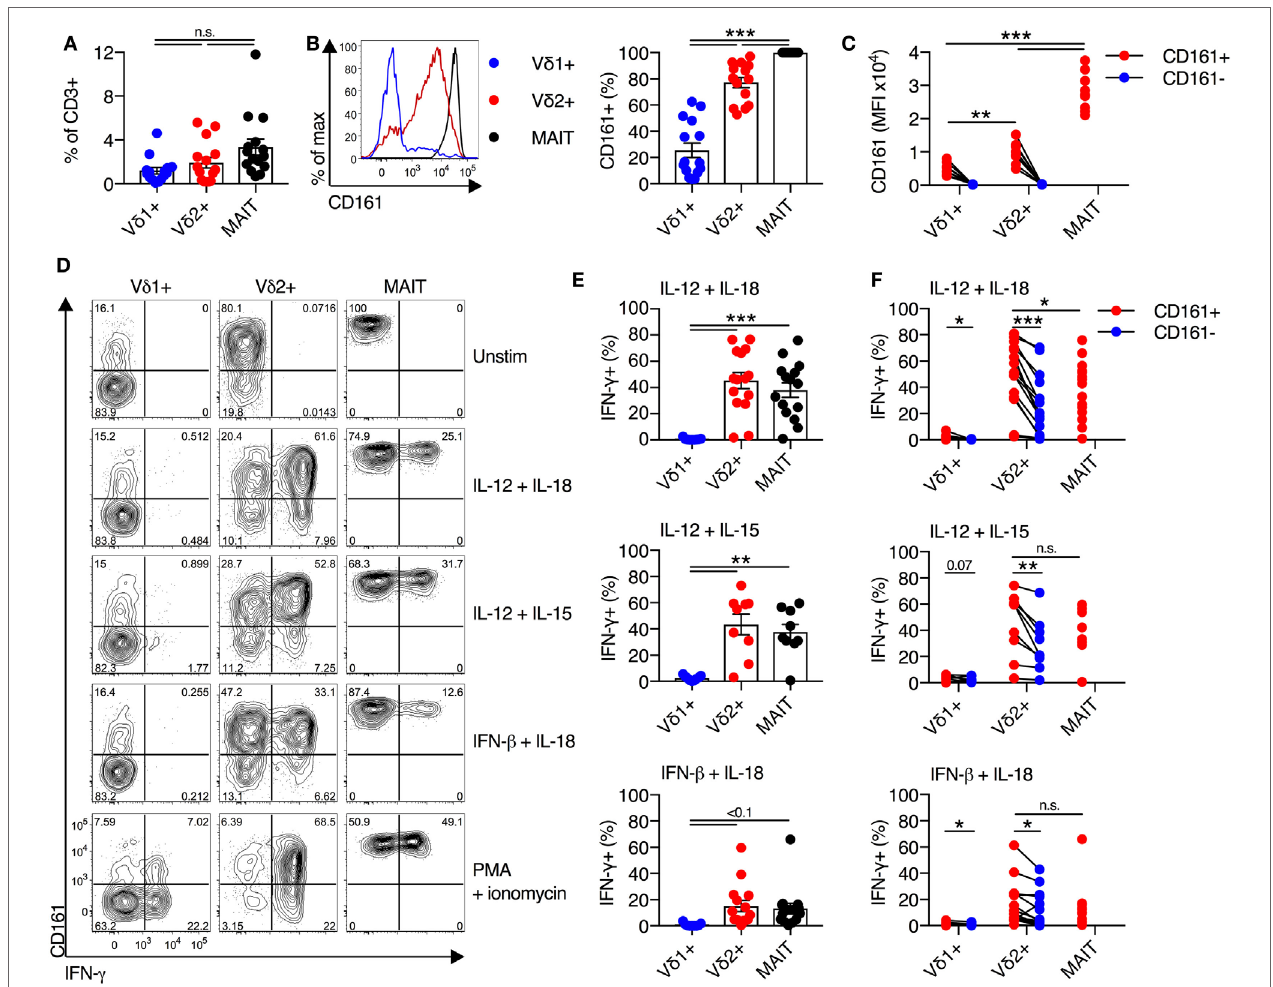
FigUre 1 | V δ 2 + γδ T cells express CD161 and produce IFN- γ in response to cytokine stimulation. (a) Frequency of V δ 1 + γδ T cells, V δ 2 + γδ T cells, and mucosal- associated invariant T (MAIT) (V α 7.2 + CD161 ++ ) cells in human blood. (B) Representative FACS plot and group averages for expression of CD161. (c) Mean fluorescence intensity (MFI) of CD161 expression on each subset. (D–F) Human peripheral blood mononuclear cells were stimulated for 20 h with the indicated cytokines (50 ng/ml). Brefeldin A and Monensin were added for the final 4 h. (D) Representative FACS plots of IFN- γ production. (e) Production of IFN- γ by each cell subset in response to the indicated cytokines. (F) Production of IFN- γ segregated by CD161 expression for each cell subset. Mean ± SEM. Symbols represent individual donors ( N = 9–15), pooled from two individual experiments, or representative of two experiments (c) . *** P < 0.001; ** P < 0.01; * P < 0.05. Repeated measures paired ANOVA with correction for multiple comparisons (a,B,e) and paired T test (c,F)